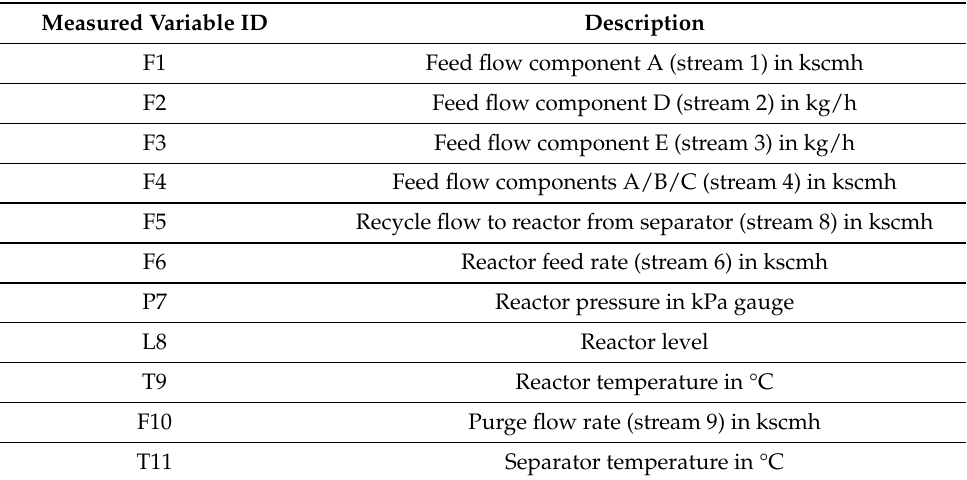
Figure A3. A schematic diagram of TEP. Table A1. Measured variables of